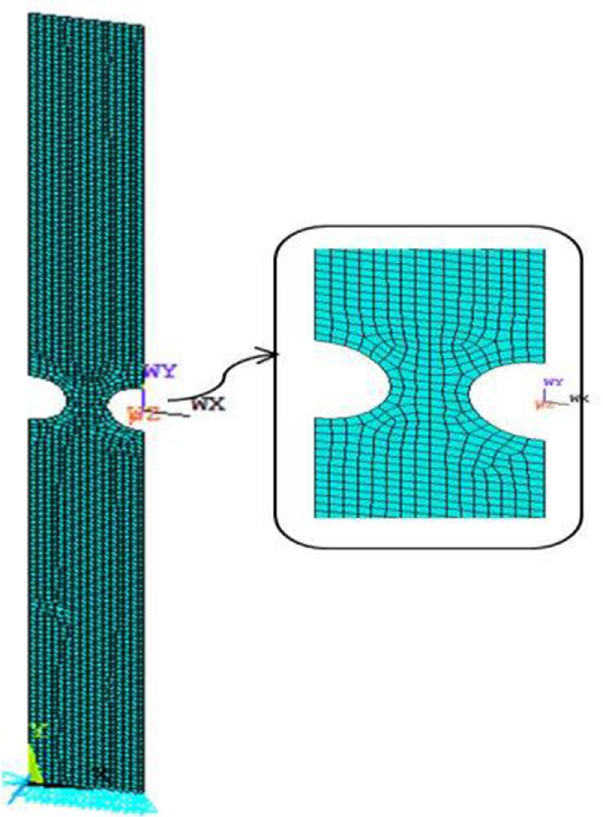
Fig. 2. ANSYS fi nite element model of the specimen.